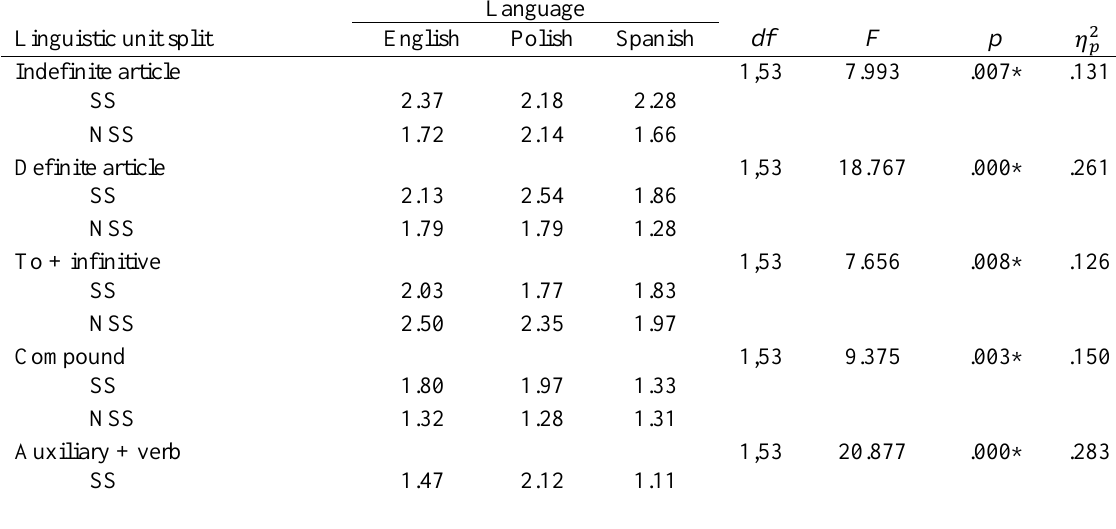
Table 7. Revisits by linguistic unit and